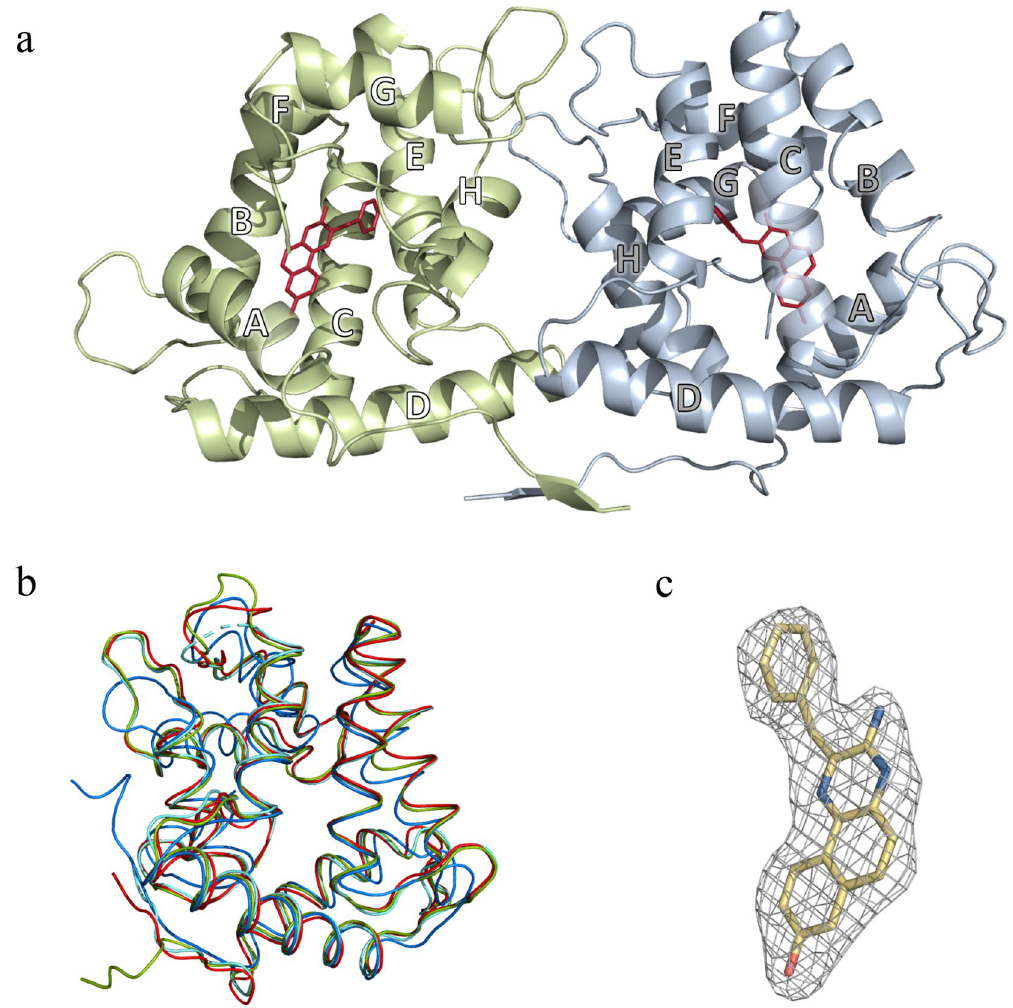
Figure 2. Crystal structure of Ca 2+ -discharged obelin- v . ( a ) Overall structure of Ca 2+ -discharged obelin- v . The helices are marked by capital letters A–H. ( b ) Superimposition of Ca 2+ -discharged obelin- v (green, PDB: 8A9S), Ca 2+ -discharged obelin W92F with no Ca 2+ (cyan, PDB: 1S36), Ca 2+ -discharged obelin bound with three Ca 2+ ions (blue, PDB: 2F8P) and obelin- v (red, PDB: 7O3U). ( c ) 2F o –F c electron density map of CTM- v molecule in the substrate-binding cavity of Ca 2+ -discharged obelin- v (chain A) countered at